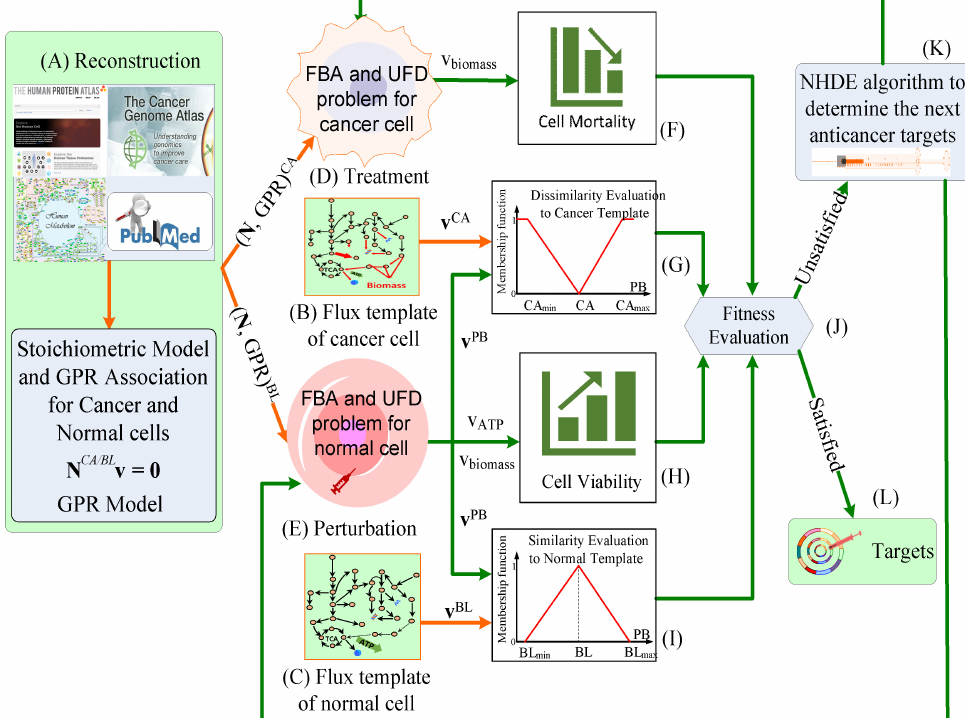
Figure 2. Work flowchart for identifying anticancer target framework. ( A ) Tissue-specific genome- scale metabolic models of cancerous (CA) and normal (BL) cells were reconstructed through biological data. ( B ) Flux distribution patterns for cancer tissue can be provided from clinical data if available; otherwise the template can be computed through FBA and UFD problem without considered dys- regulated restriction. ( C ) Flux distribution patterns for normal tissue can be provided from clinical data if available; otherwise the template can be computed through FBA and UFD problem without considered dysregulated restriction. ( D ) A set of anticancer targets are identified by the nest hybrid differential algorithm (NHDE), and provided to compute the flux distributions for each cancer treatment. ( E ) The same targets are provided to compute the perturbated flux distributions of normal cell during treatment. ( F ) Using cancer cell growth rate, cell mortality is evaluated. ( G ) Using mem- bership function, cancer template and perturbated fluxes are used to compute dissimilarity